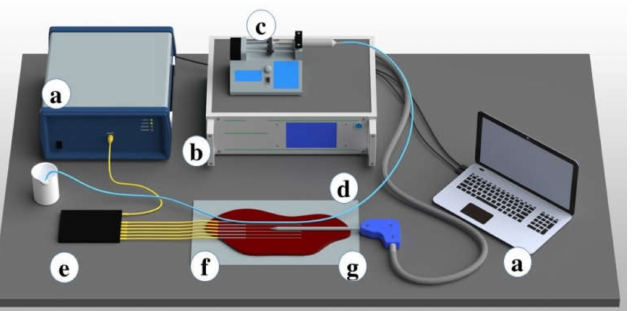
Figure 1. Schematic view of the setup for the radiofrequency ablation of the phantom. The setup includes ( a ) OBR and data logging; ( b ) customized RF generator for the ablation; ( c ) the syringe pump; ( d ) medical tube positioned in parallel to the active electrode; ( e ) six optical fiber sensing arrays; ( f ) parenchymal tissue; and ( g ) an applicator of the RF generator inserted in tissue between fibers 3 and